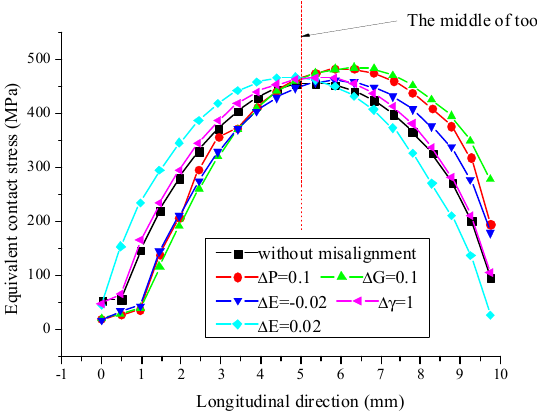
Figure 19. Contact stress distribution for the symmetric crowned modification driving opinion (Case1) along the tooth width in different installment conditions.